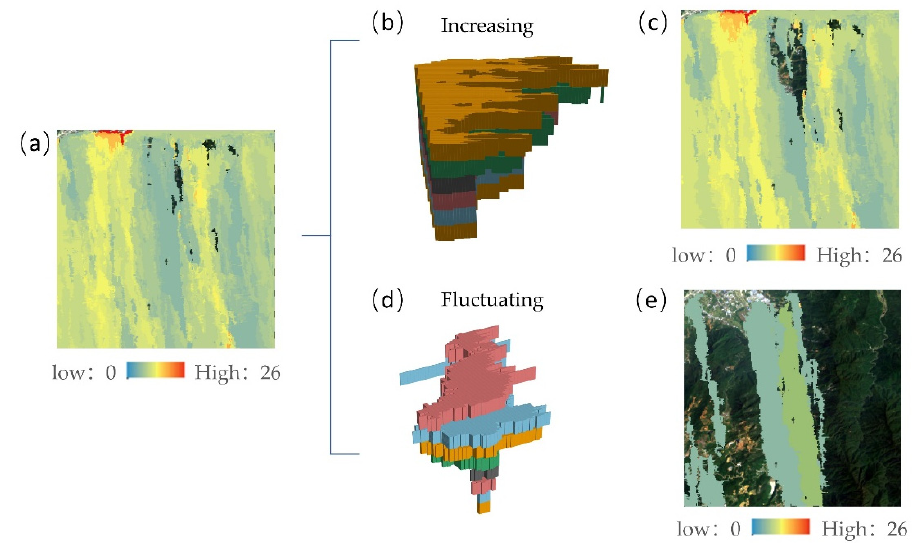
Figure 8. ( a ) Spatial distribution of the mean time length of the LL IST-cube. ( b ) Actual LL and increasing IST-cube diagram, containing six layers representing a six-year duration, with an increasing number of pixels per year, conforming to the LL and increasing IST-cube classes. ( c ) Spatial distribution of the mean time length for the LL and increasing IST-cube classes. ( d ) Actual LL and fluctuating IST-cube diagram, containing eight layers representing an eight-year duration, with a fluctuating number of pixels per year, conforming to the LL and fluctuating IST-cube classes. ( e ) Spatial distribution of the mean time length for the LL and fluctuating IST-cube classes.